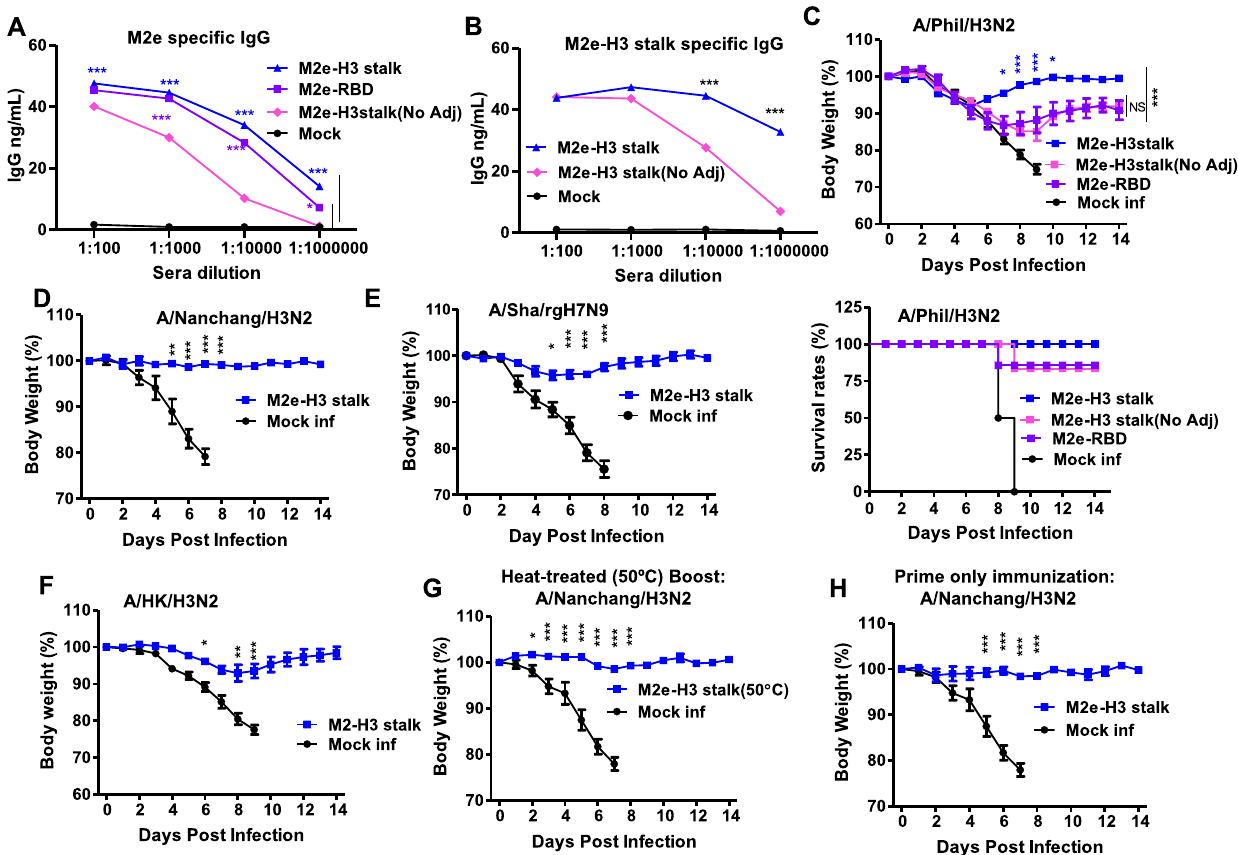
Fig. 4 Adjuvanted M2e-H3 stalk vaccination induces heterologous cross-protection against group 2 in fl uenza A viruses. A M2e-speci fi c serum IgG antibody levels in the different vaccine groups. B Serum IgG antibodies speci fi c for M2e-H3 stalk antigen in the M2e-H3 stalk groups with (M2e-H3 stalk) and without adjuvant (M2e-H3 stalk/No adj). C – H The groups of mice ( n = 5, 6 – 8 weeks old) vaccinated (prime or prime-boost) with M2e-H3 stalk protein (20 μ g + /- adjuvant) or M2e-RBD (20 μ g plus adjuvant) were intranasally challenged with group